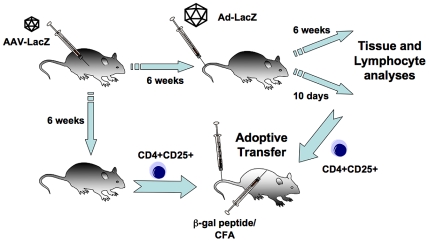
Flow chart of experimental design.First, AAV2-LacZ hepatic gene transfer was performed. A secondary I.V. delivery of Ad-LacZ (or Ad-GFP) was performed 6 weeks later or in naïve mice to provoke an immunotoxic response. Samples were taken and experiments were performed 10 and 45 days after Ad delivery. Splenic CD4+CD25+ T cells were adoptively transferred to naïve mice 6 weeks after AAV2-LacZ gene transfer or 10 days after secondary Ad-LacZ delivery. Recipient mice were immunized with a peptide encoding the dominant CD8+ T cell epitope for β-gal in this strain. All animals were C57BL/6 mice.